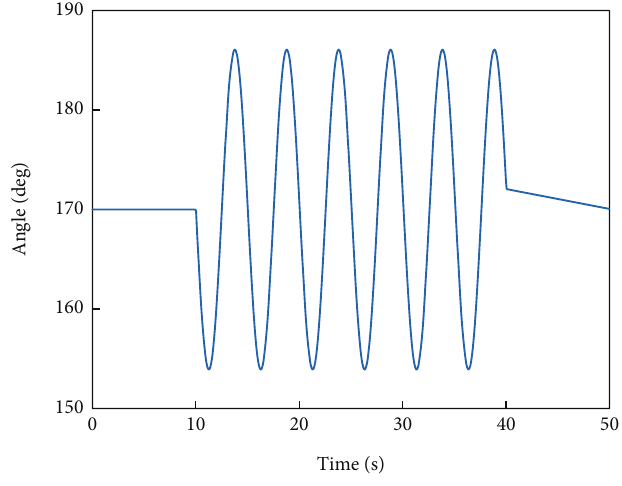
Figure 19: Changing process of the turntable azimuth